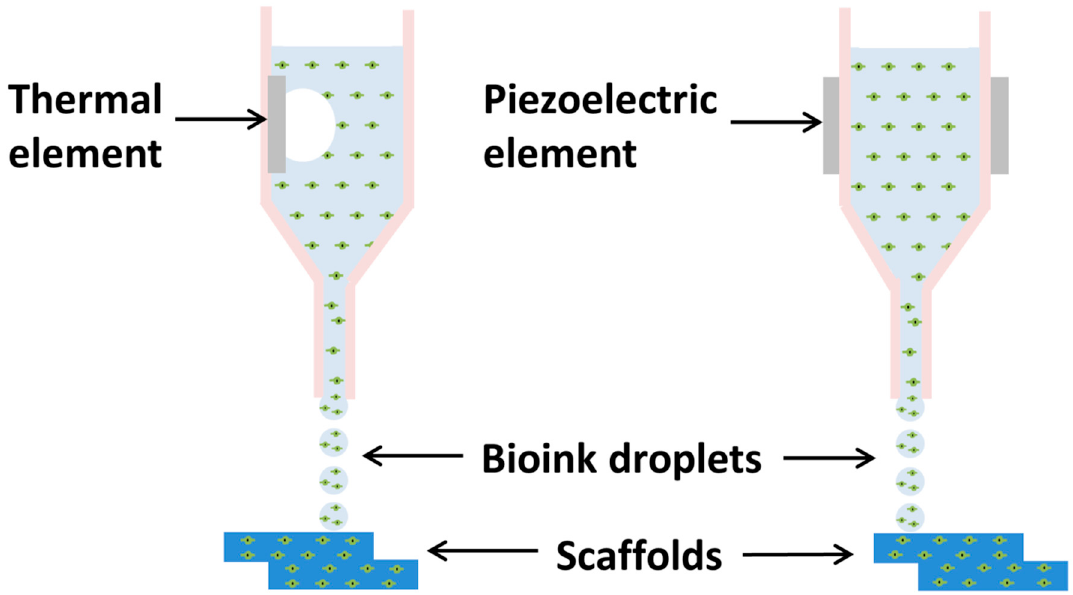
Figure 2. Schematic of Inkjet-based Bioprinting. Thermal inkjet uses heat-induced bubble nucleation that propels the bioink through the micro-nozzle. Piezoelectric actuator produces acoustic waves that propel the bioink through the micro-nozzle.